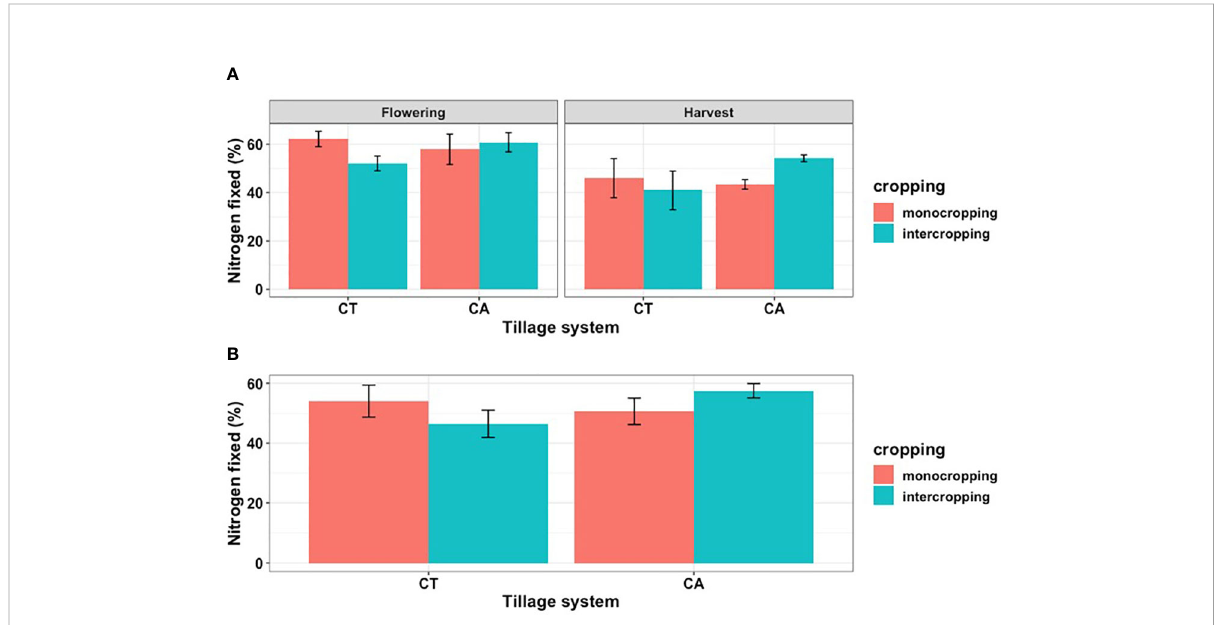
FIGURE 3 The percentages of N fi xed as affected by cropping system, (A) at different sampling times, and (B) the overall.